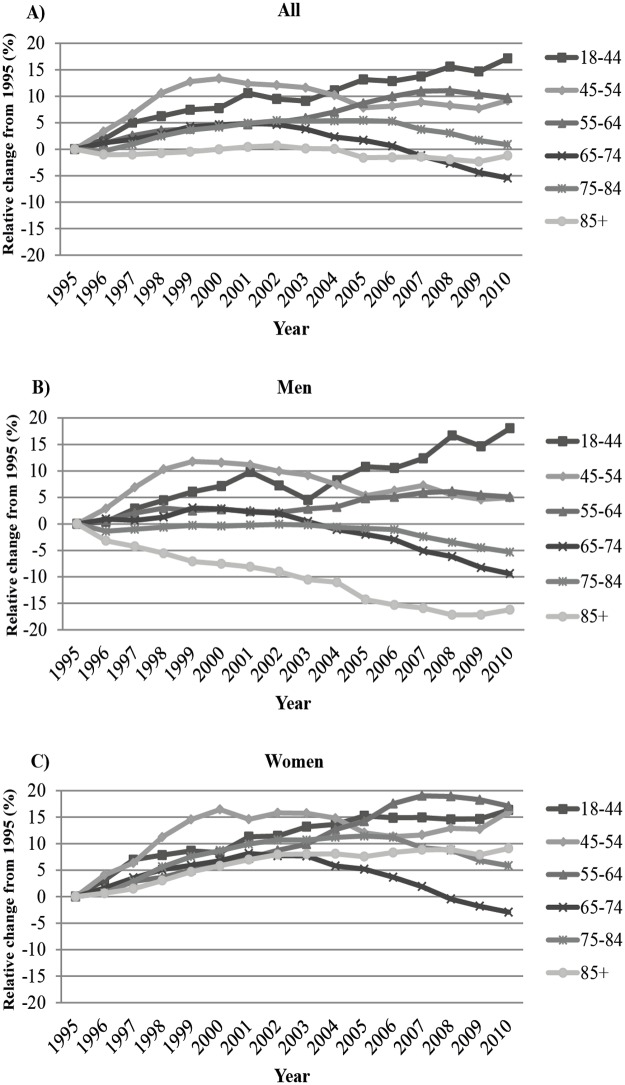
Relative change in the prevalence of IS divided by age groups in A) all patients, B) in men, and C) in women.